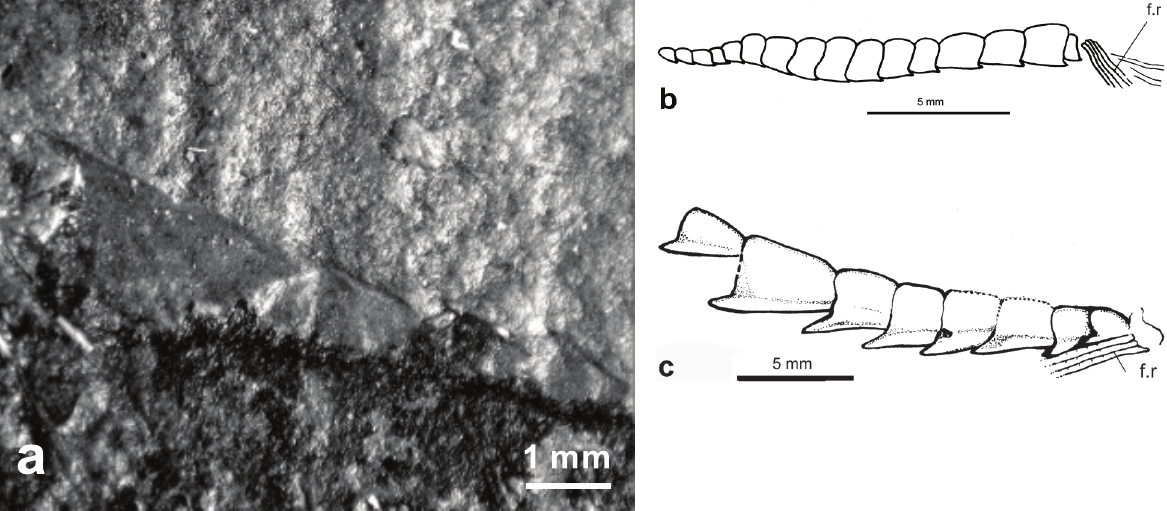
Figure 11. † Scutatuspinosus itapagipensis Santos and Corrêa 1985: ( a ) posteriormost predorsal scutes of DGM 1164-P; ( b ) pre- pelvic scutes of DGM 1224-P; ( c ). Post-pelvic scutes of DGM